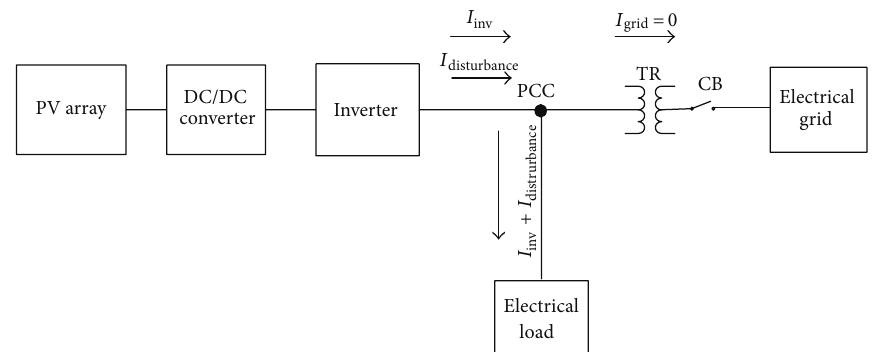
Figure 5: General structure of active methods.